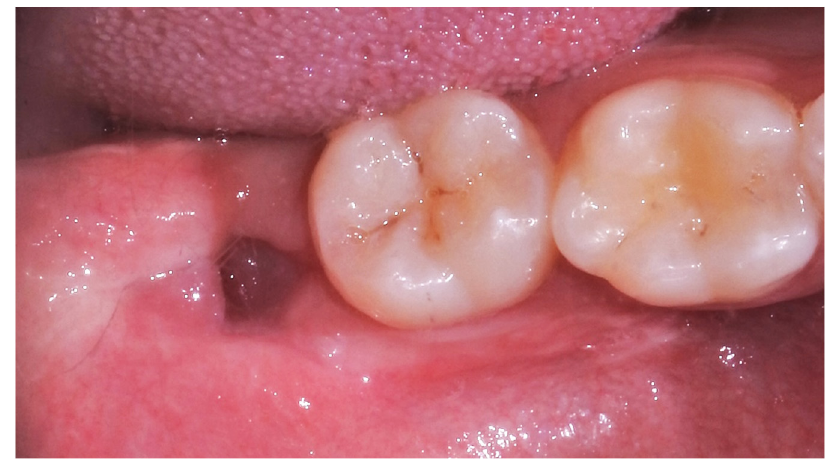
Figure 4. Post-surgical site (4.8) evaluation at 21-day follow-up.